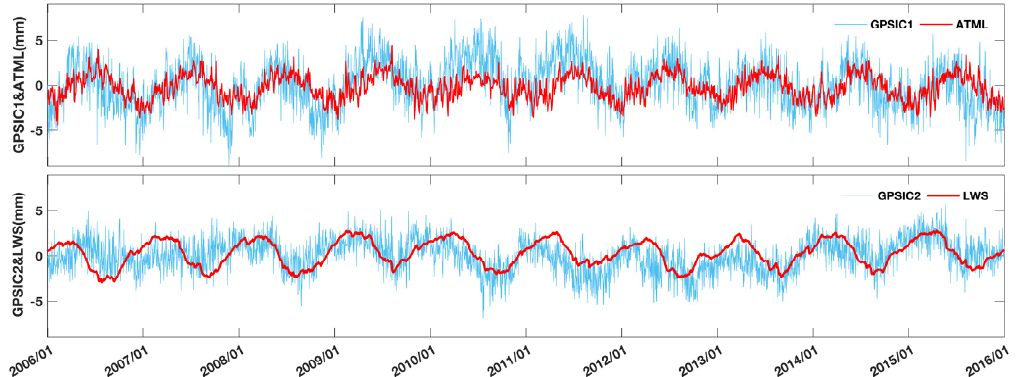
Figure 9. Comparison of the GPS_ICs (calculated with IC1 and IC2) and mass loading deformation signals (ATML and LWS). The upper figure shows GPS_IC1 and the ATML, and the lower figure shows GPS_IC2 and the LWS.